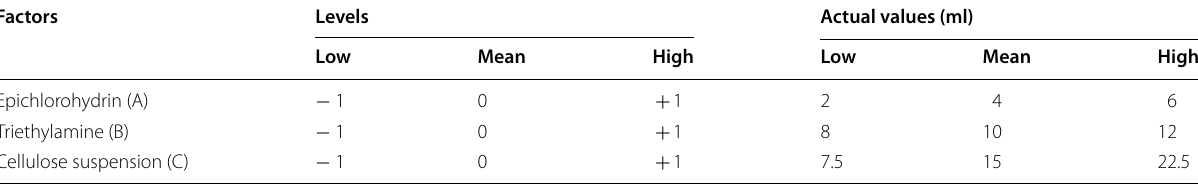
Table 2 The coded and actual values of the variables for the synthesis of cationic fibers based on Box–Behnken design